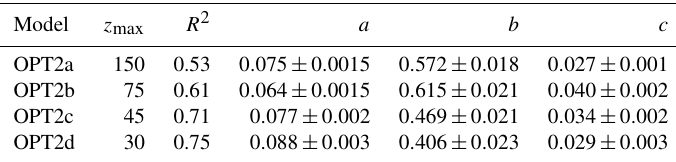
Table 2. Parameters derived for optical models using BGC-Argo float data. For each version of OPT2 the regression is performed in the depth range indicated by z max . Data points are averaged for layers of 15m